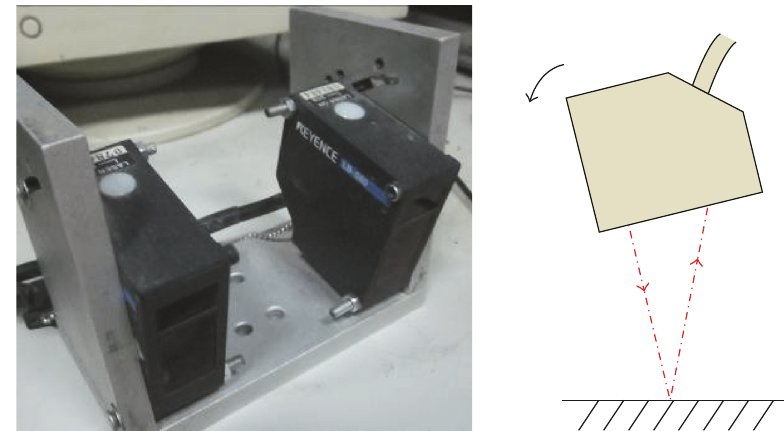
Figure 2: KEYENCE laser displacement sensors.